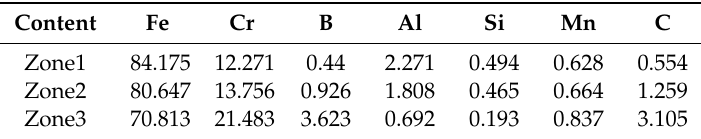
Figure 4. The X-ray pattern of high aluminum and chromium Fe-B-C coating.